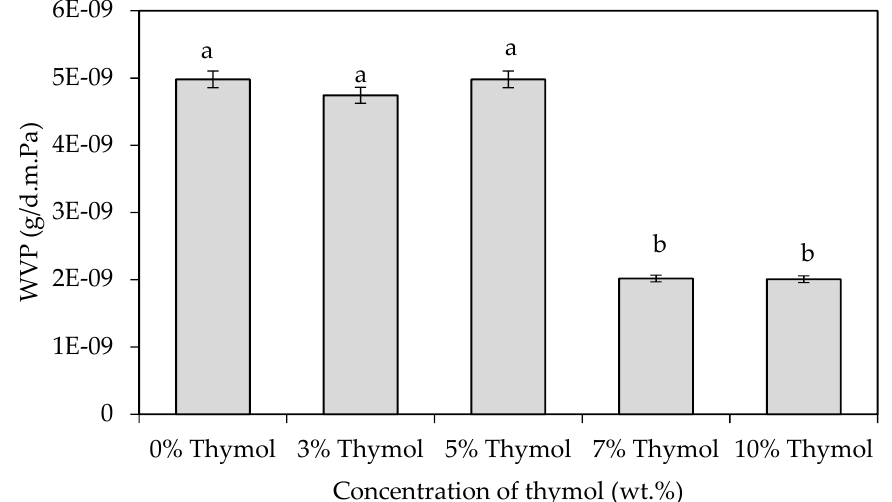
Figure 4. WVP of starch/CNF bionanocomposite films incorporated with different concentrations of thymol. Different letters in the same graph indicate a statistically significant difference ( p < 0.05).